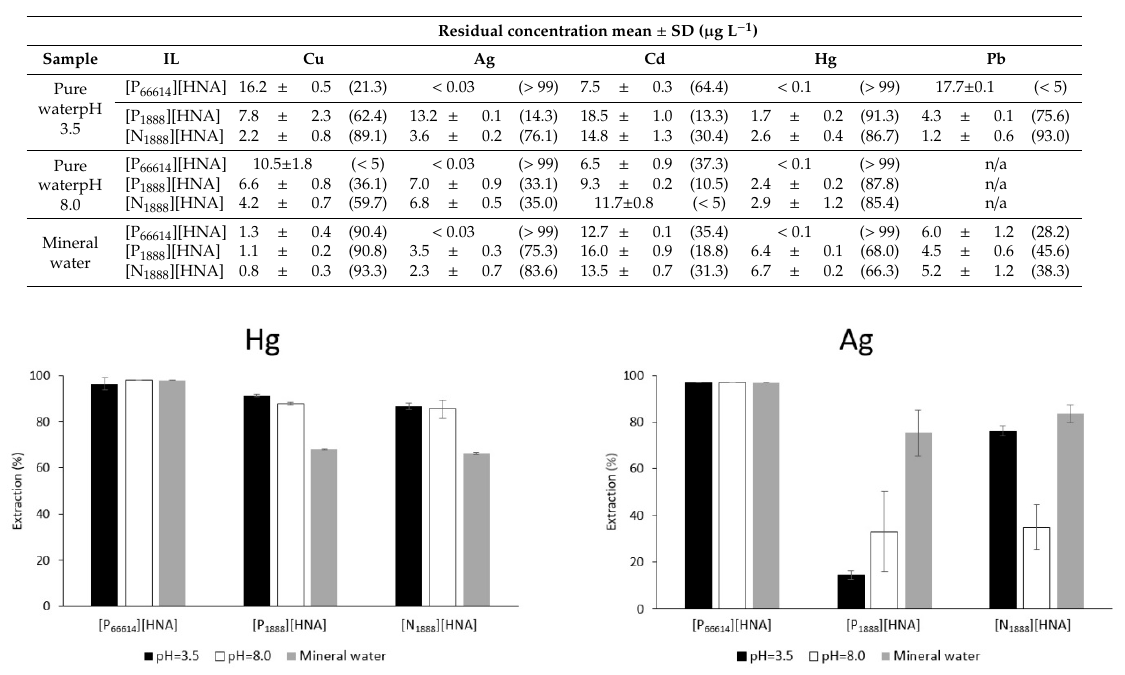
Table 2. Residual concentrations of metals after extraction experiments f rom pure water at pH 3.5, pure water at pH 8.0 and spiked natural mineral water for an extraction time of 2 h; extraction efficacies in percent are given in brackets, n=3. n/a = not applicable: no metal in solution in reference samples after 2 h.